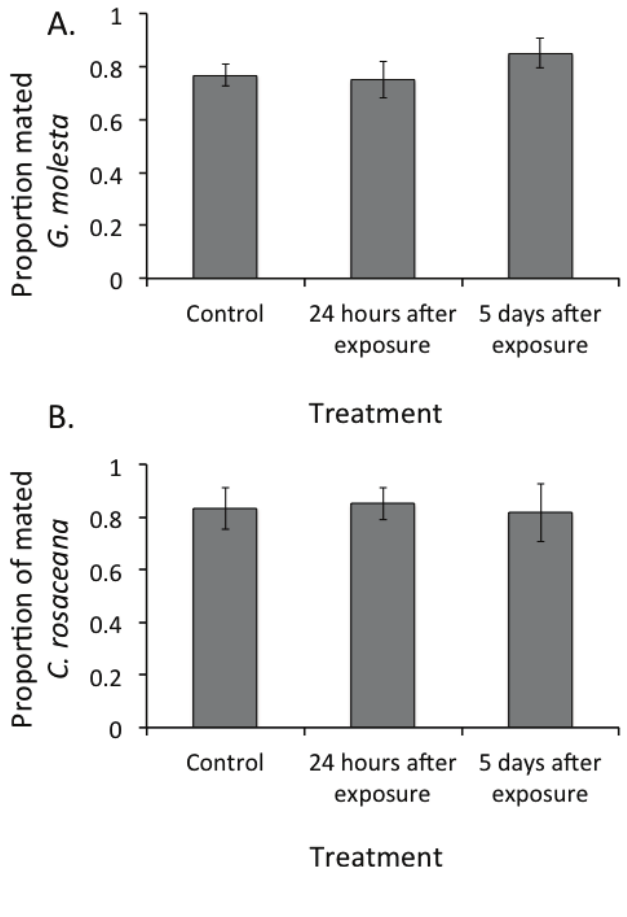
Figure 2. Mating status of female Grapholita molesta ( A ) or Choristoneura rosaceana ( B ) following a 24 hours interval in confined 1-L cages with a conspecific male under no pheromone exposure, and 24 hours or 5 days following pheromone